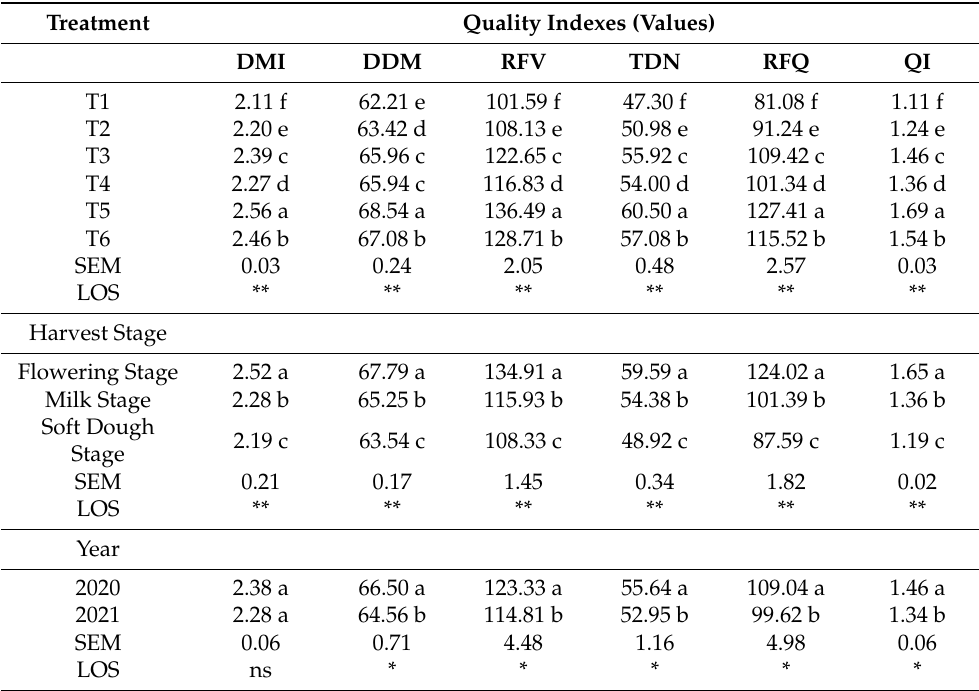
Table 5. Forage quality of forage cultivated by wheat and ryegrass sole-cropped and mixed with alfalfa harvested at different maturity stages (DM%).